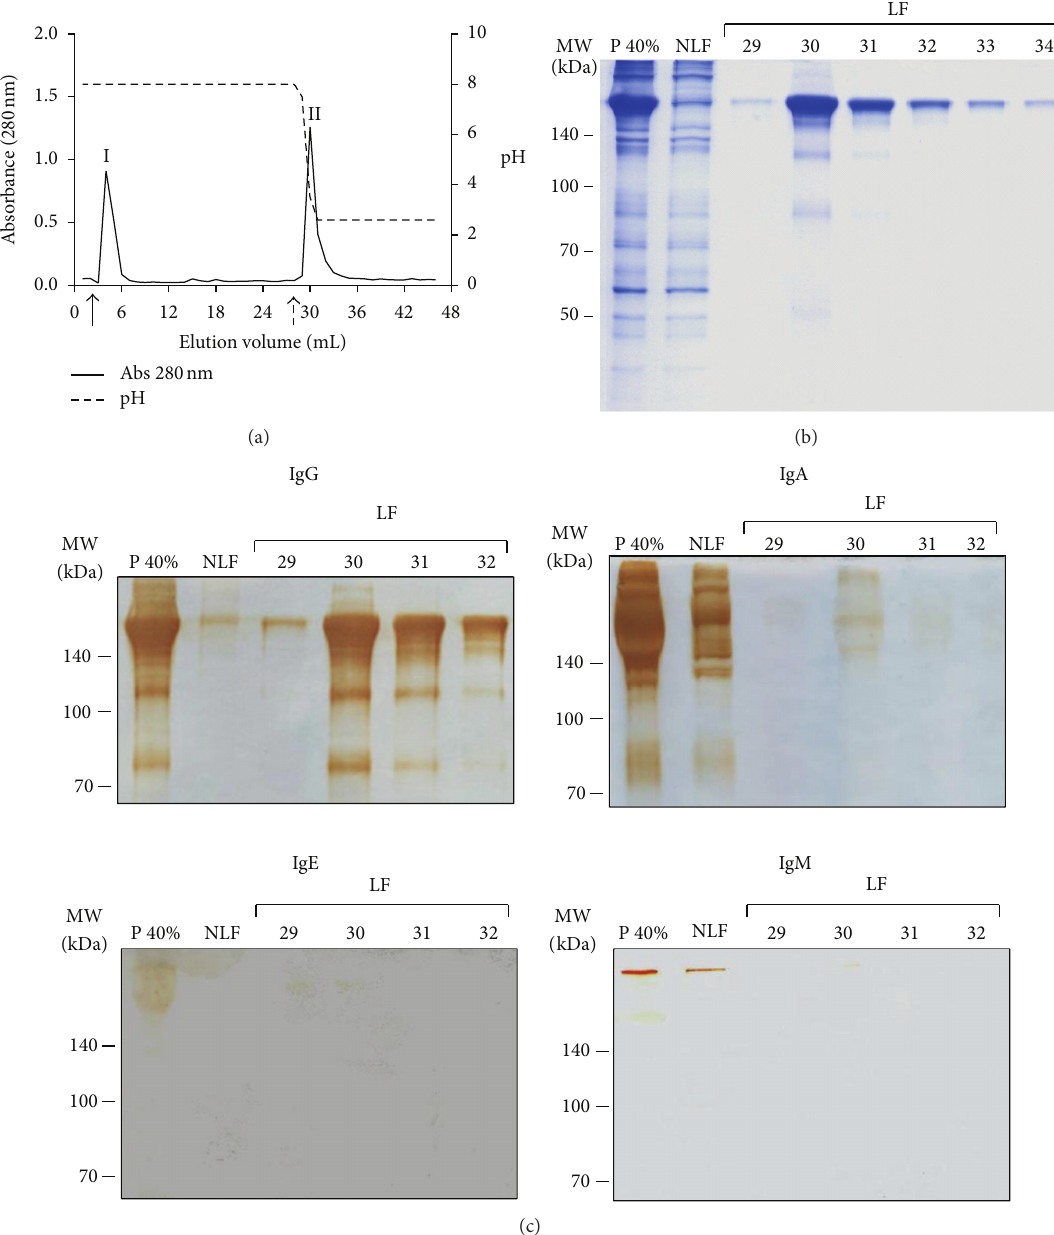
Figure 3: (a) Representative chromatogram of the total human IgG purification by affinity chromatography in protein G-agarose obtained from the 40% ammonium sulfate precipitated fraction (P 40%) of a serum pool. I—elution peak of P 40% nonligand fraction after washing with 0.02 M phosphate buffer pH 8.0 (black arrow); II—elution peak of P 40% ligand fraction after washing with 0.1 M glycine buffer pH 2.6 (dashed arrow). Data are expressed in absorbance (280nm). Elution volume consisted of 1mL in each tube. Values of pH were also measured in each elution tube. (b) Electrophoretic profile in SDS-PAGE 8% stained with blue silver. NLF—nonligand fraction, LF—ligand fraction, corresponding to the tubes 29–34. Markers of molecular weight (MW) are indicated on the left in kilodaltons (kDa). (c) Immunoblots for detection of IgG, IgA, IgE, and IgM in the serum fractions after purification in protein G-Agarose as shown in (b). Bands were revealed with DAB as described in